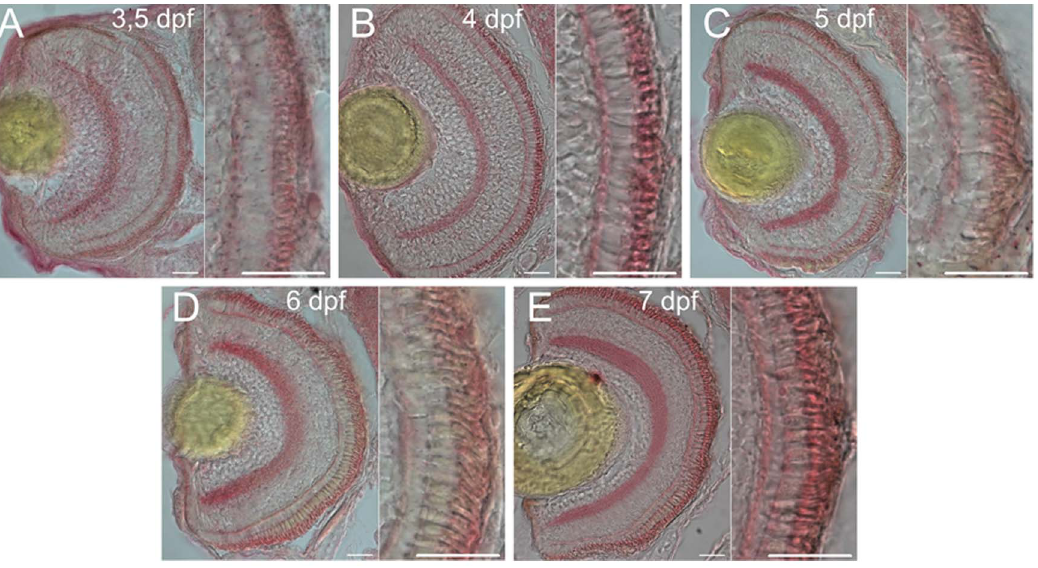
Figure 2. Temporal expression profile of zGC3 during larval development. Cryosections of larval eyes were probed with the anti-zGC3 antibody (1:400) at 3.5 – 7 dpf (A–E) and stained with Fast Red. Left part of each panel is a section through the whole eye, right part shows the